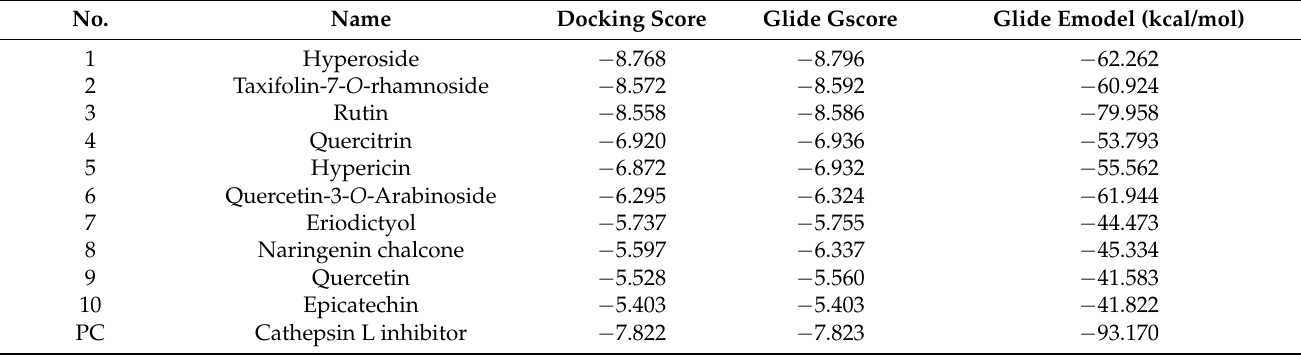
Table 6. Docking of the 10 active compounds in the H. kouytchense insect gall extracts, along with the positive control cathepsin L inhibitor, against Cat L